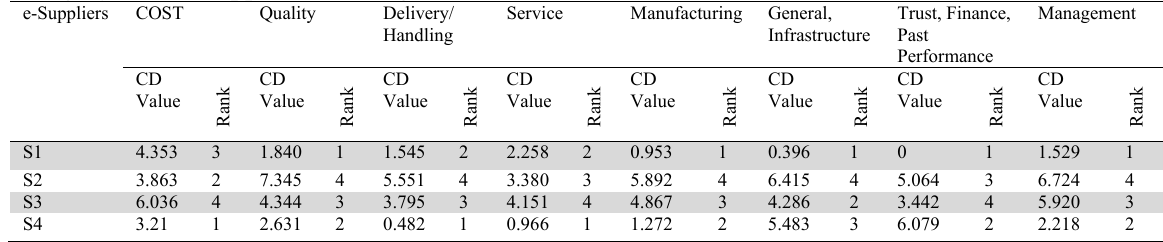
Category wise E-suppliers Ranking Results